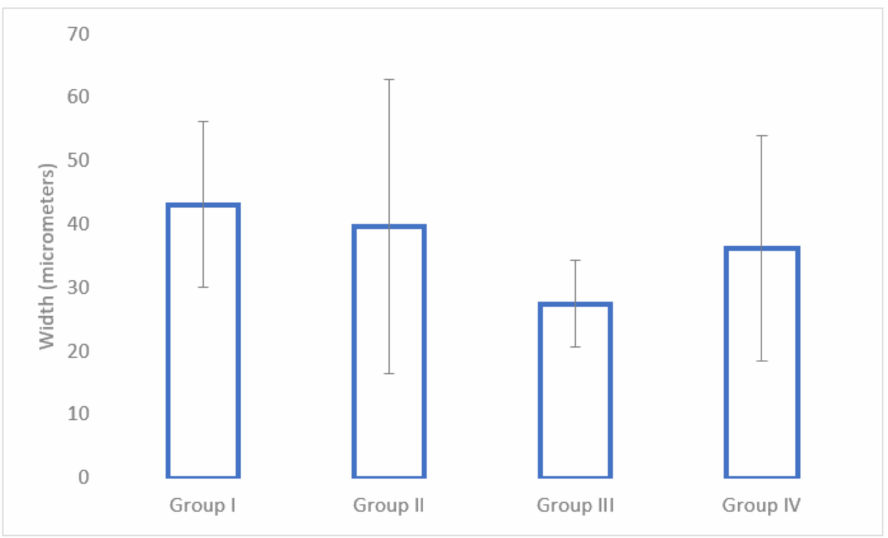
Figure 8. The average width of the cortical bone tissue at the peri-implant region.